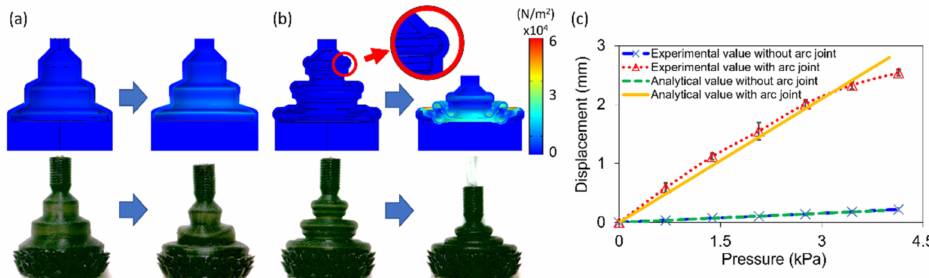
Figure 2. FEM analysis results and the actuator with vacuum applied for characterization of the soft actuator: ( a ) Collapsible funnel-shaped design. ( b ) Arc joint design. ( c ) Displacement of actuators depending on applied pressure.